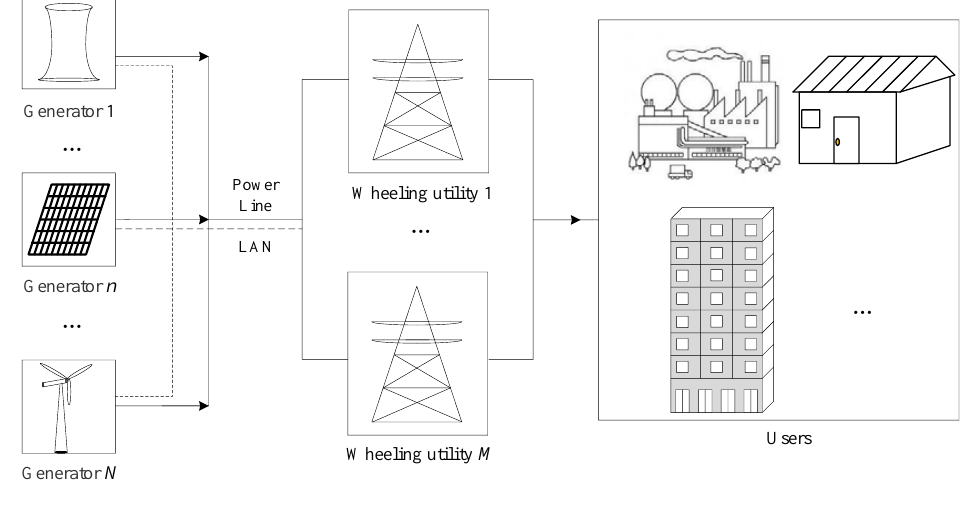
Figure 1. Figure of wheeling